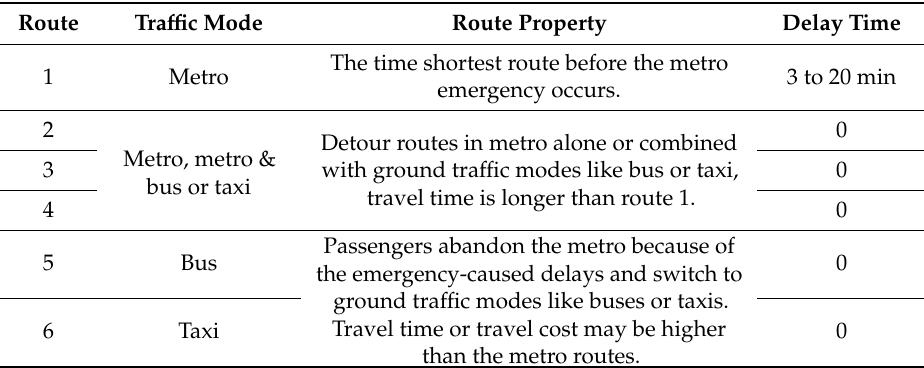
Table 1. Route properties in the survey.